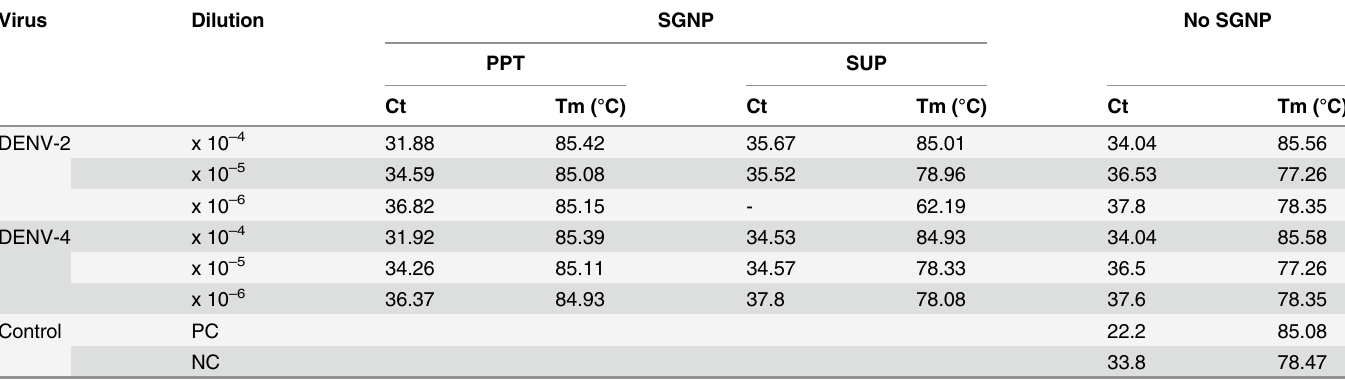
Table 2. Capture and concentration of dengue viruses 2 and 4 (DENV-2 and -4) using DS25-GNP in the presence of 1% human serum.